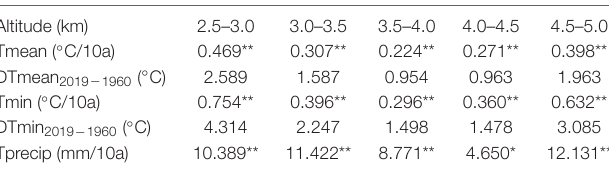
TABLE 2 | Trends of MAAT, mean annual minimum air temperature, annual mean precipitation, and absolute difference (DT) of temperature over the QTP from 1960 to